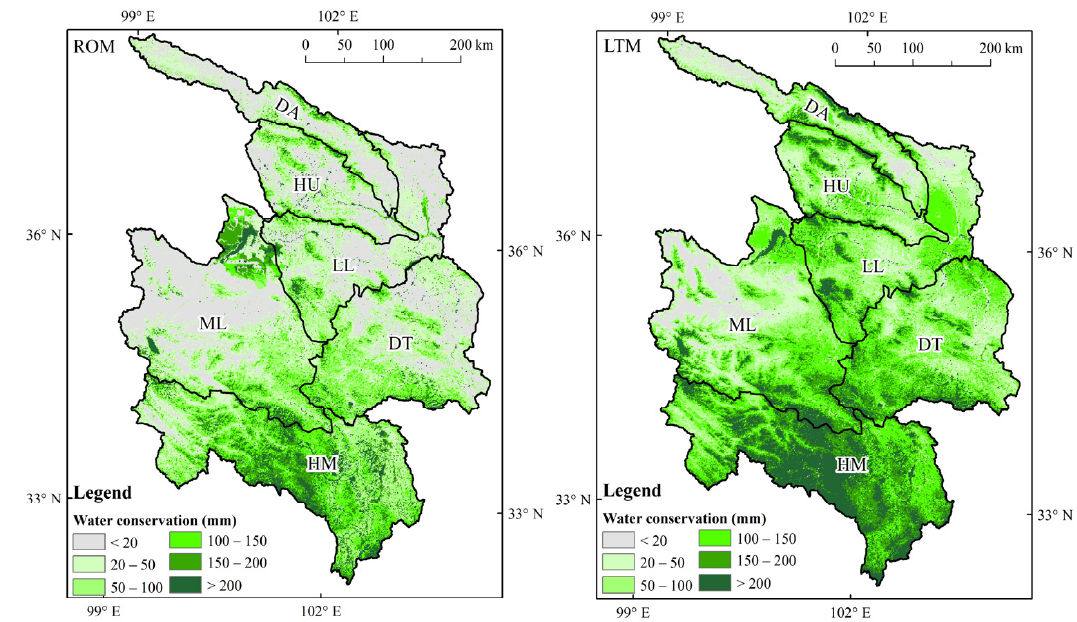
Figure 8. Spatial distribution of water conservation calculated by two methods.